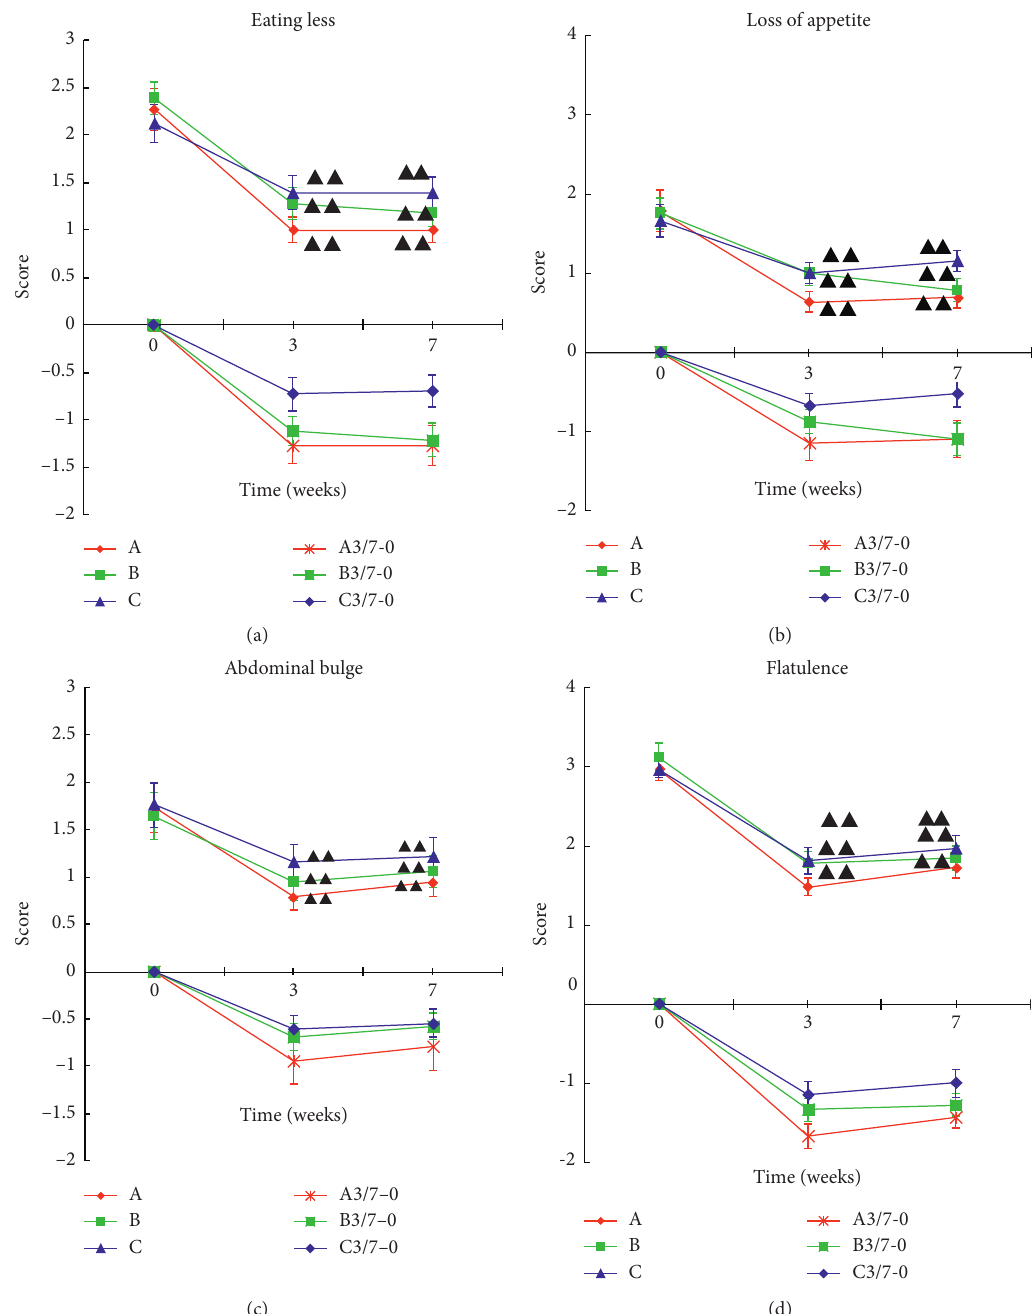
Figure 3: Comparison of four symptom scores in each group of patients. 3-0 and 7-0 are the scores obtained by the 3rd and 7th weekend scores minus the 0th week. Data were expressed as mean ± M ( n � 33). ΔΔ P < 0 . 01, compared to